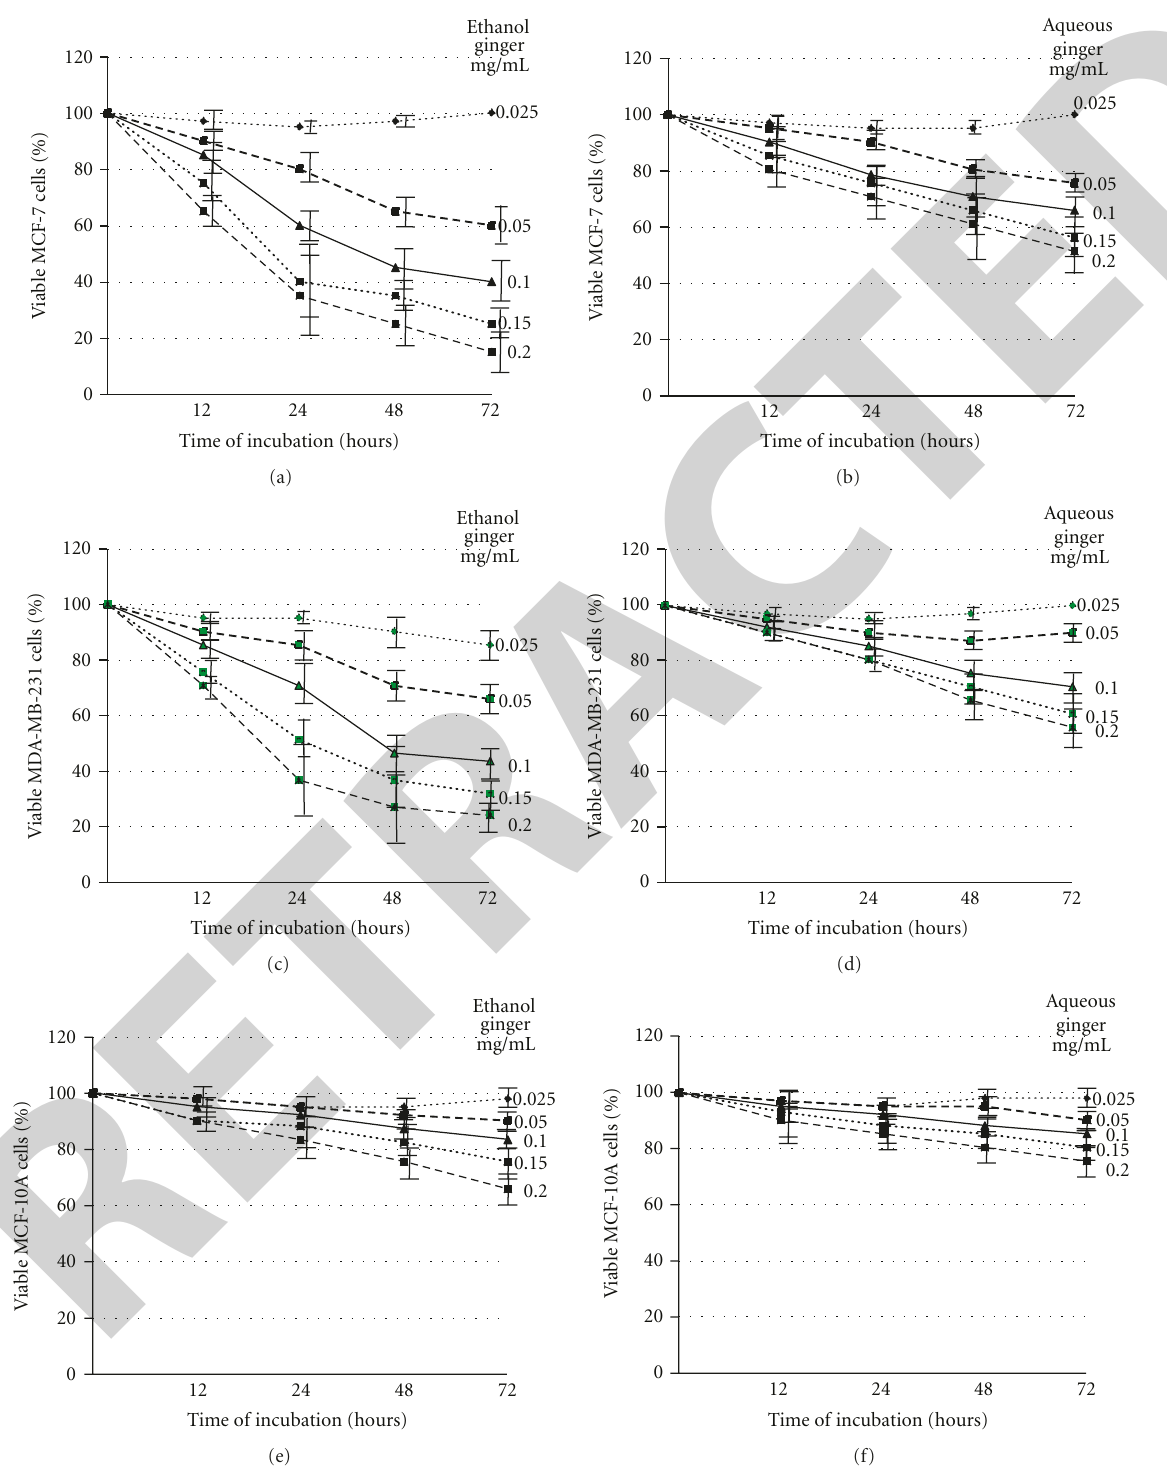
Figure 1: Ethanol and aqueous extracts of ginger inhibit proliferation of MCF-7 and MDA-MB-231 cells. MCF-7 (a and b), MDA MB-231 (c and d), and MCF-10A (e and f) cells were incubated with the indicated concentrations of ethanol (a, c, and e) or aqueous (b, d, and f) extract of ginger for displayed time intervals. The cell viability was measured by trypan blue dye exclusion assay, as described in Materials and Methods. The experiments were repeated five times in triplicates, and cell viabilities at each dose of ginger extracts were expressed in terms of percent of control and reported as the mean ±